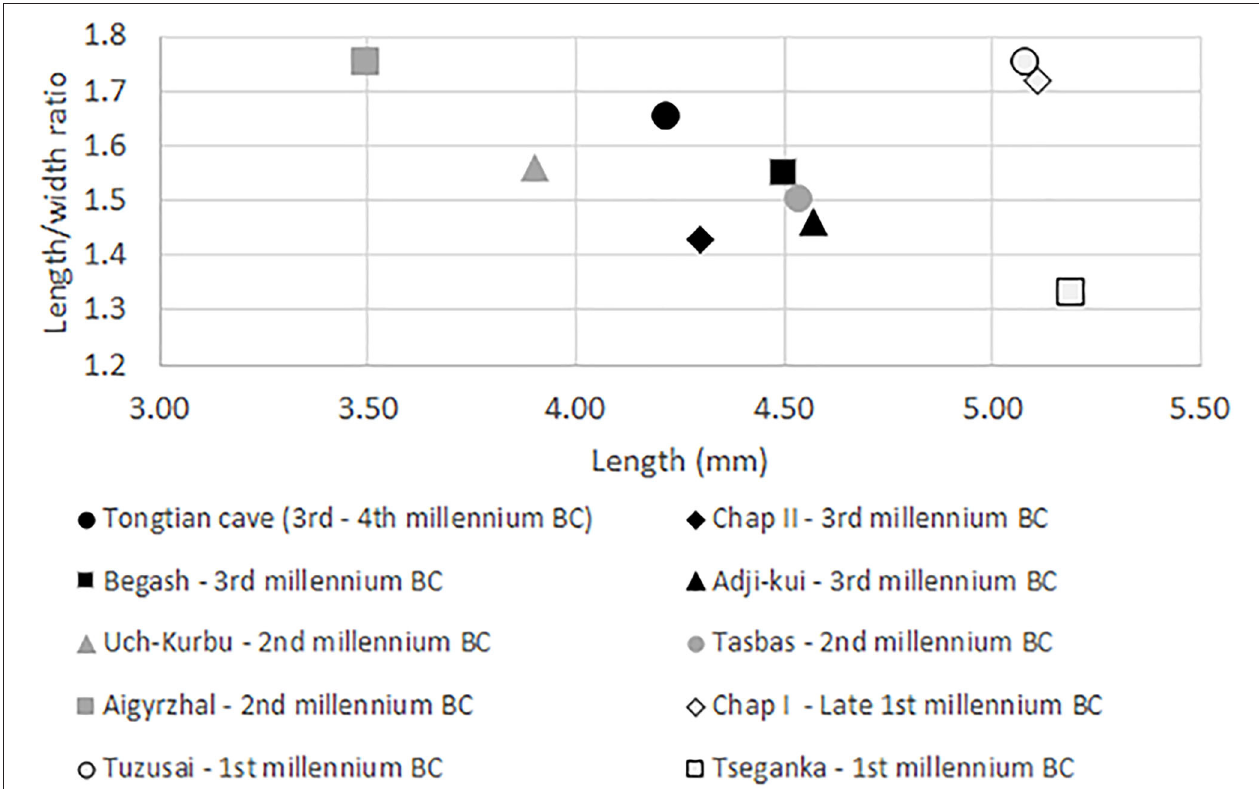
FIGURE 5 | Staked line of barley length and width from archaeological sites in Central